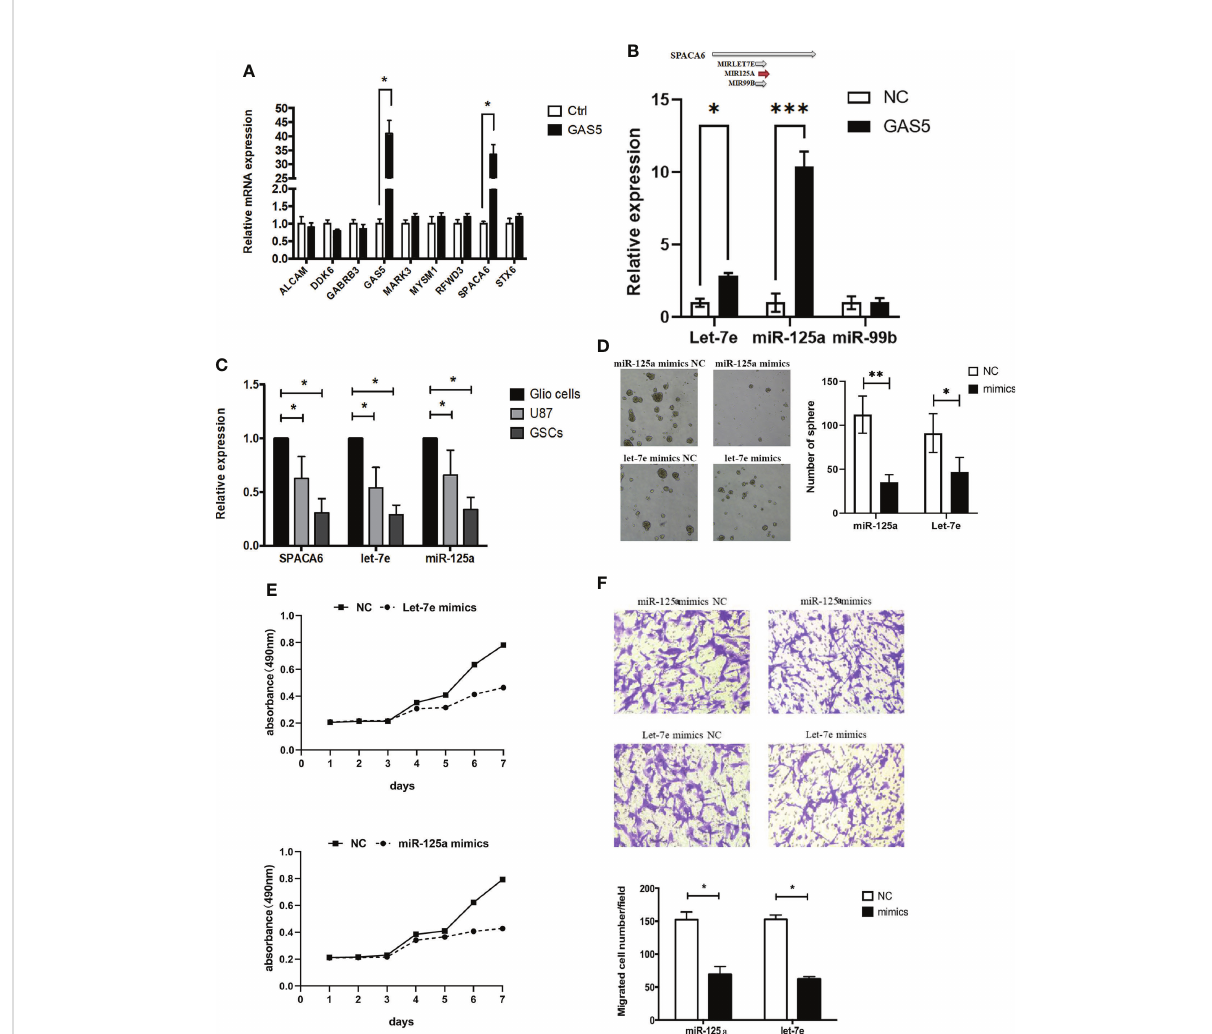
FIGURE 4 LncRNA-GAS5 restrains the proliferation and migration of GSCs through Let-7e and miR-125a by modulating SPACA6. (A) qRT-PCR analysis of the expression of several genes that are signi fi cant in the RAP assay in GAS5 overexpression and parental GSCs (n=3). GAPDH is used as a reference gene. (B) Upper: Three miRNAs with SPACA6 as host gene (data from https://www.ncbi.nlm.nih.gov/gene/406910). Lower: qRT-PCR analysis of the expression of let-7e, miR-125a and miR-99b in GAS5 overexpression and parental GSCs (n=3). GAPDH is used as a reference gene. (C) qRT-PCR analysis of the expression of SPACA6, let-7e and miR-125a respectively in glial cells, GBM cells and GSCs (n=3). GAPDH is used as a reference gene. (D) Tumor spheres formation assay showed miR-125a and let-7e mimics affected the number and size of tumorspheres (n=3). (E) CCK-8 assay revealed the effect of miR-125a and let-7e mimics on the proliferation of GSCs with the cells are cultured for seven consecutive days and the absorbance of the cells are measured daily (n=6). (F) Transwell assay of the effect of miR-125a and